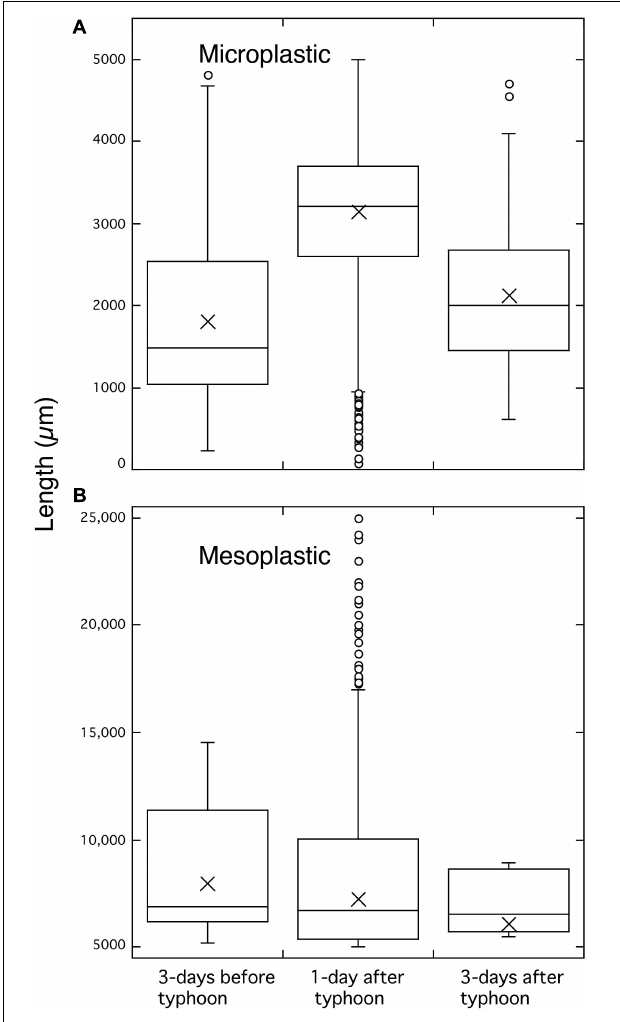
FIGURE 4 | Changes in the length ( µ m) of (A) microplastics and (B) mesoplastics 1-day before and 1-day and 3-days after typhoon passage. The line in the middle of the boxes represents the median values; the tops and bottoms of the boxes denote the 75 and 25% quartiles, respectively, and the top and bottom of the errors show the maximum and minimum value, excluding outliers (circles). Crosses denote the mean data.